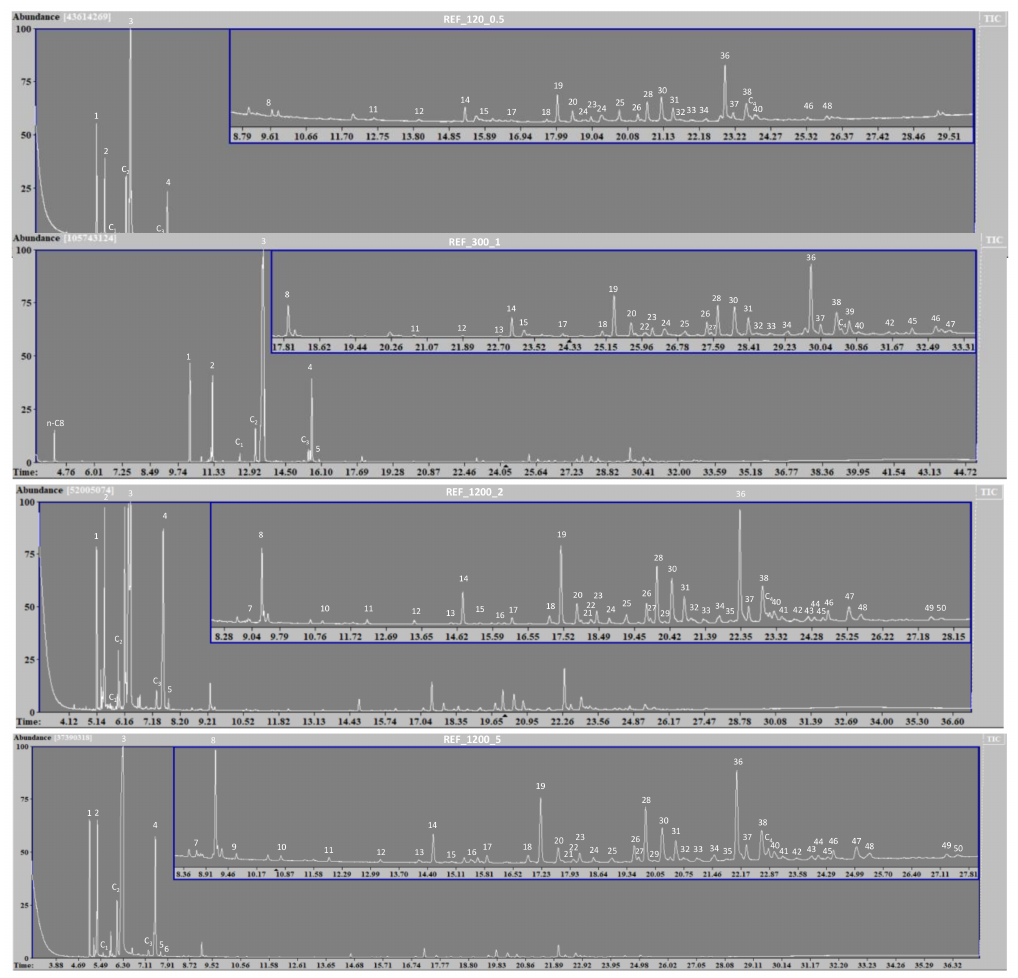
Figure 1. GC-MS spectra of reference samples produced with different amounts of foragers and varying vortex times. All identified peaks are numbered and the corresponding identified compounds are listed in Table 1. Compounds found over different samples carry the same number in every sample. Unidentified peaks were either contaminants (e.g., phtalate compounds from the plastic containers used to contain the ants) or unidentifiable compounds. Table 1. List of components identified in the GC-MS spectra represented in Figure 2. Numbers refer to the peak numbering in Figure 2. Indices are used to indicate in which samples the components were identified: * present in all samples, ** present in all samples except Ant_ref_1, *** present in both Ant_ref_3 and Ant_ref_4 and finally **** only present in Ant_ref_4. Components presented as C x are components which were not attributed to Monomorium species before; they were not included in Figure 2. Representation of the components is as follows: Alkanes (C n ), alkenes (C n :1), dienes (C n :2), monomethylalkanes (MeC n ), dimethylalkanes (diMeC n ), and trimethylalkanes (triMeC n ). List of Components Present in the Hexane Wash of M.